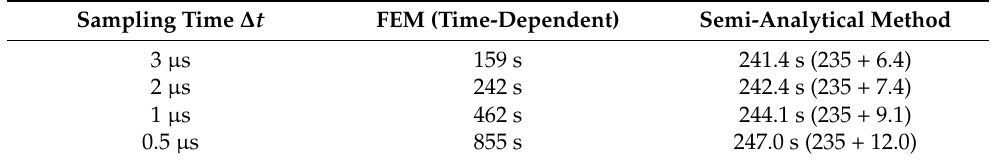
Table 1. Comparison of the computational time between the FEM and semi-analysis method.